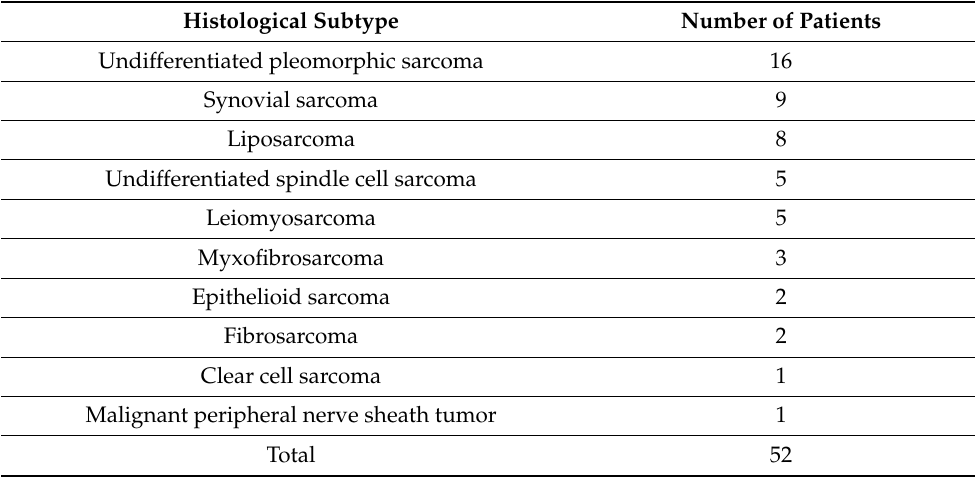
Figure 1. Images of a primary soft-tissue sarcoma (undifferentiated pleomorphic sarcoma) of the right upper leg (( a ) contrast- enhanced T1w TSE with fat-sat axial; ( b ) PET/MRI; ( c ) DWI b-1000; ( d ) ADC-map; ( e ) contrast-enhanced T1w TSE with fat-sat coronal). The large and partially necrotic tumor manifestation (23 mm) shows a pathologic glucose metabolism (SUVmax: 15.1; SUVmean: 7.5) and parts of restricted diffusion (ADCmean 1491; ADCmin 487). The reference standard revealed a grade 3 tumor with a good histopathological treatment response (regression grade 2), and metastatic spread could be identified. Table 2. Distribution of histological subtypes of soft-tissue sarcomas for all patients included in this